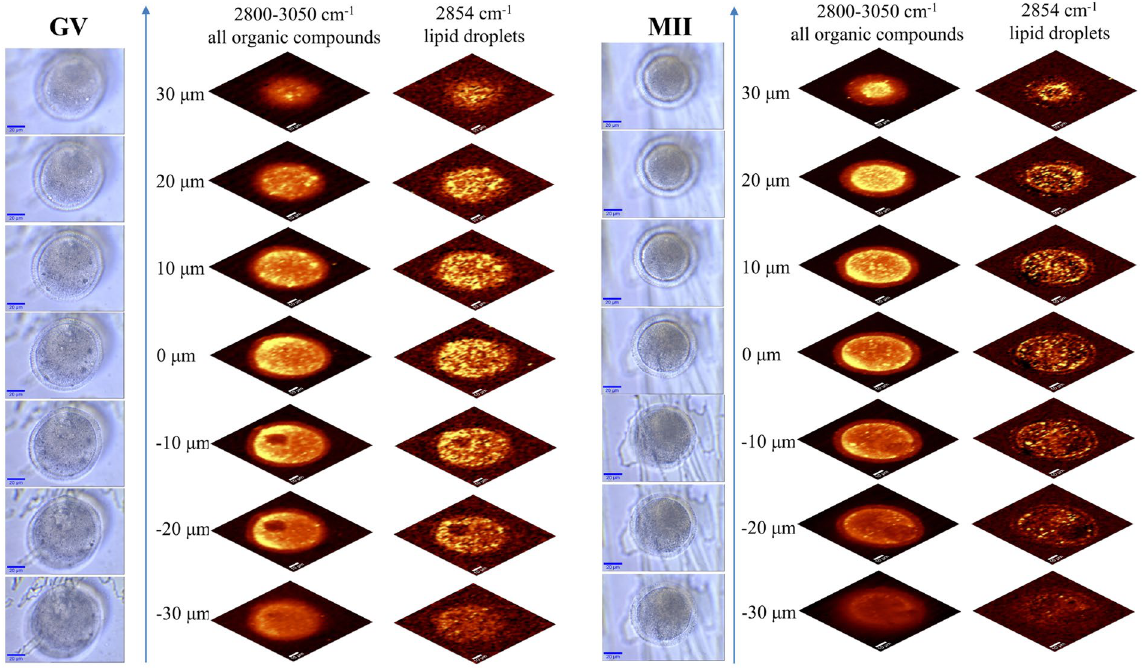
Figure 4. Confocal “optical slicing” through living GV (left side) and MII (right side) oocytes. The images acquired at 7 different vertical positions through the cells, 10 μ m apart in each case, are from left to right for each oocyte: visible images; integration Raman maps of bands intensity related to organic compounds; and lipids, respectively. The yellow color corresponds to the highest relative intensity of the integrated band related to the distribution of compound or group of compounds. Spectra were acquired at intervals of 1.5 μ m in each two dimensional